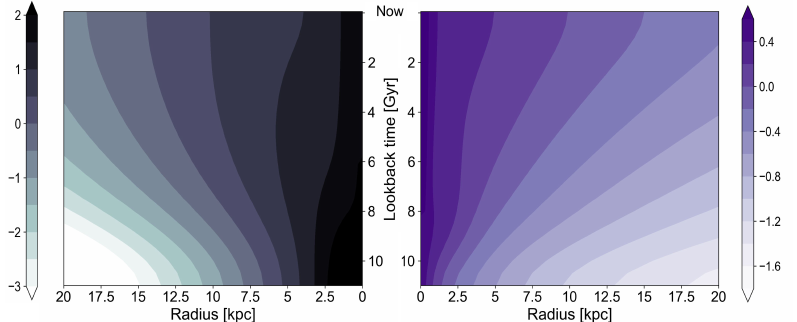
Figure 5. Evolution of the galactic model’s radial distribution of the star formation surface density ( left ) and the metallicity ( right ). As a function of the galactocentric radius R and lookback time, the color codes are in units of M d pc ´ 1 Gyr ´ 1 and Z { Z d (both in logarithmic scale, as shown by the vertical color